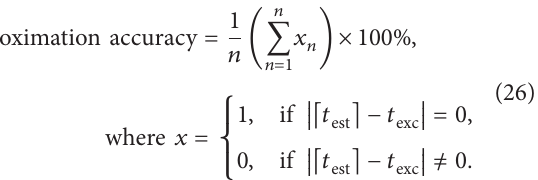
a significant reduction in processing speed by more than 98% of the discrete-time